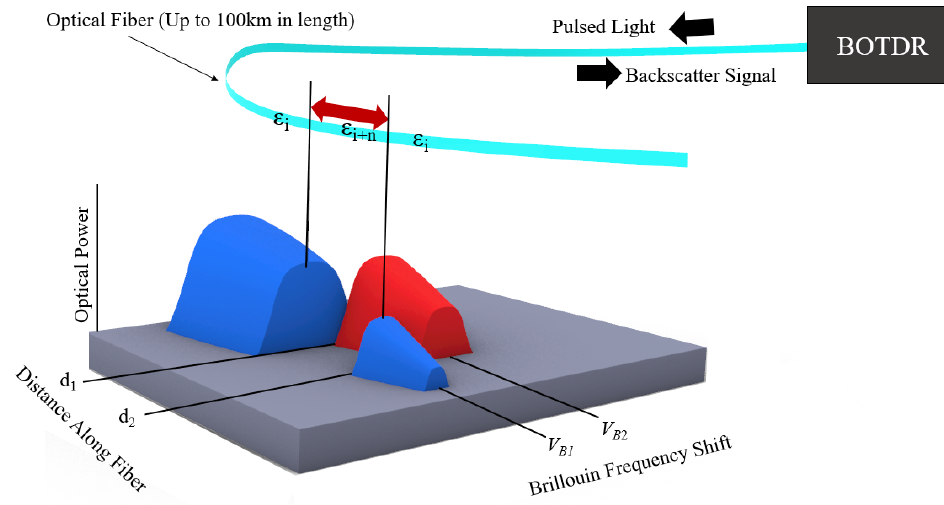
Figure 1. BOTDR measurement principle.